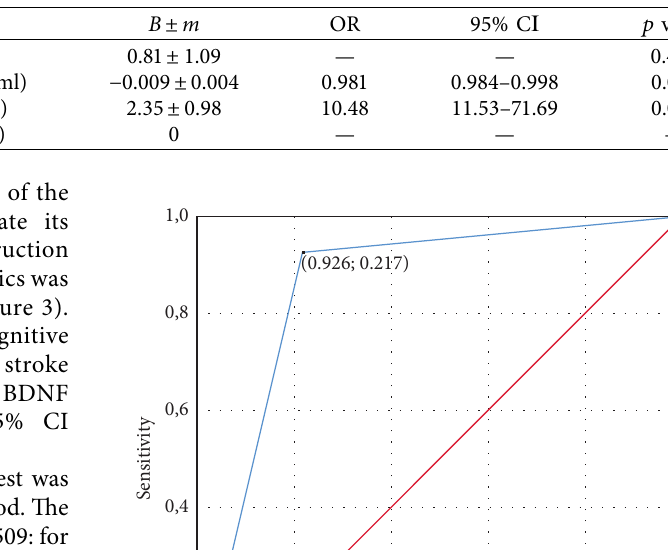
Figure 2: BDNF serum levels in patients with ischemic stroke at the 1st and 14th days of the acute period in comparison with the control group. Table 2: Scores for factors ranked by the strength of infuence on the presence of cognitive disorders in the acute period of ischemic stroke in ascending order.